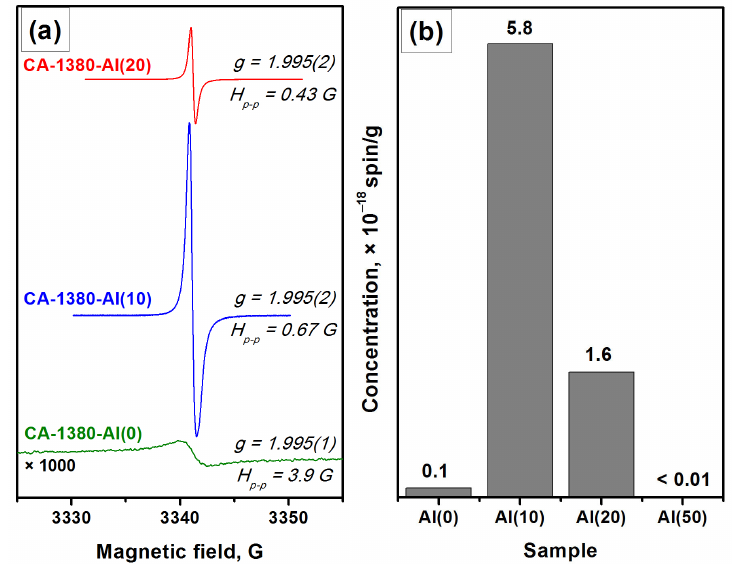
Figure 6. EPR spectra for a series of samples calcined at 1380 °C ( a ) and concentration of F + -like centers registered for these samples ( b ).